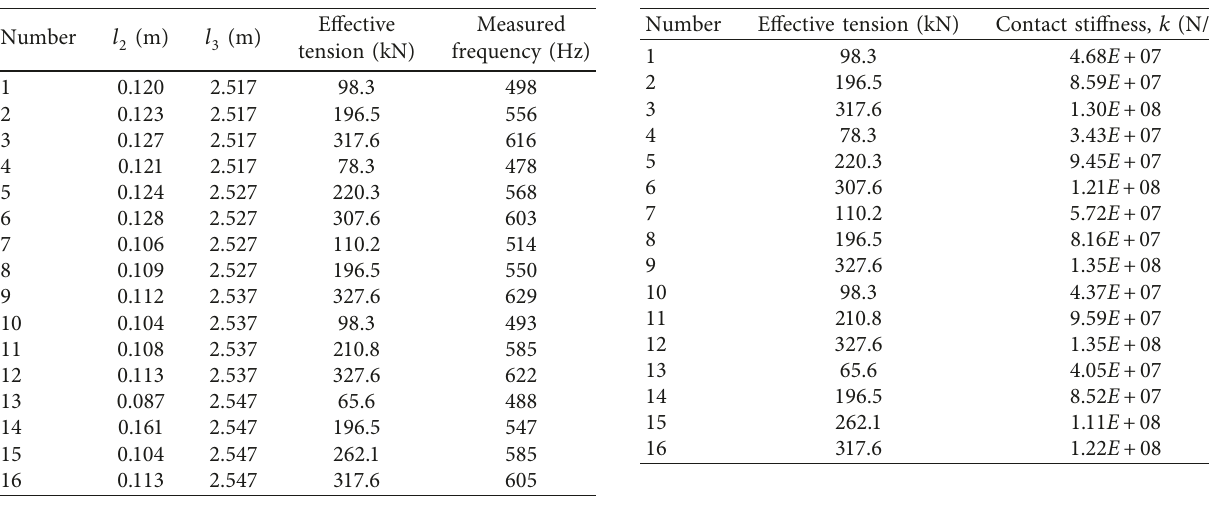
Table 6: Contact stiffness k values and effective tensions from the field test.